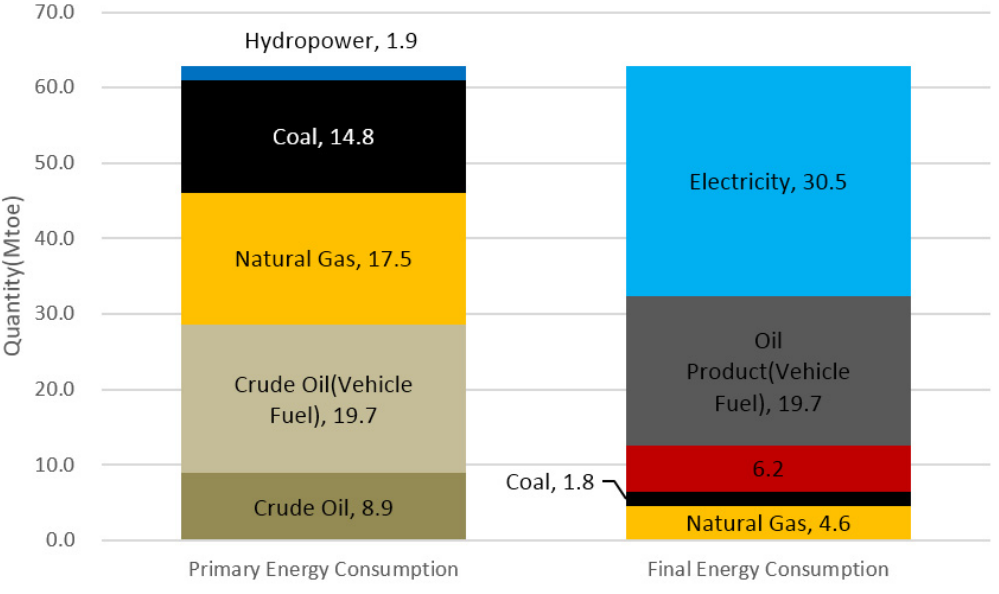
Figure 10. Energy consumption in end-use sectors in Malaysia in 2011.